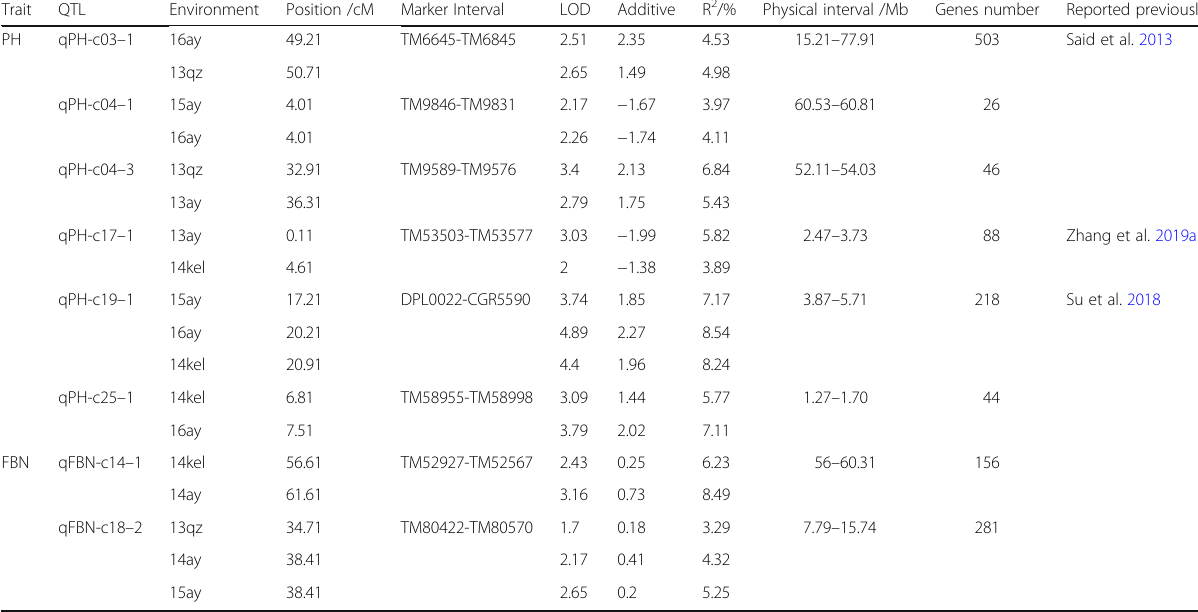
Table 3 The stable QTLs for agronomic traits identified by the composite intervalmapping (CIM) in multiple environments